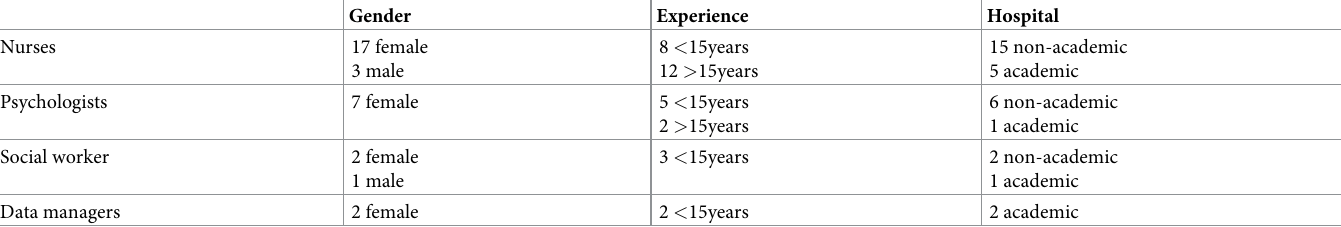
Table 2. Overview of MOC attendance per profession by gender, years of experience and type of